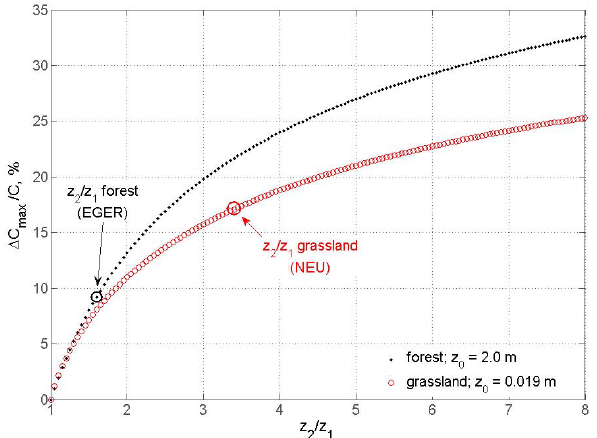
Fig. 3. Minimal relative precision requirements ( 1C max / C in %) for neutral stability and a range of measurement height ratios z 2 / z 1 for forest and grassland. Additionally indicated are z 2 / z 1 values for the sites used in this study.